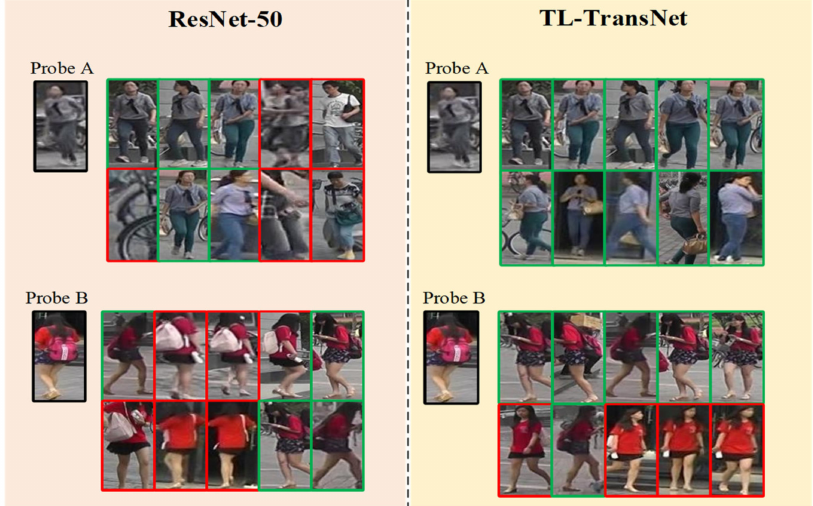
Figure 8. Top 10 visualization results of the rank-list on